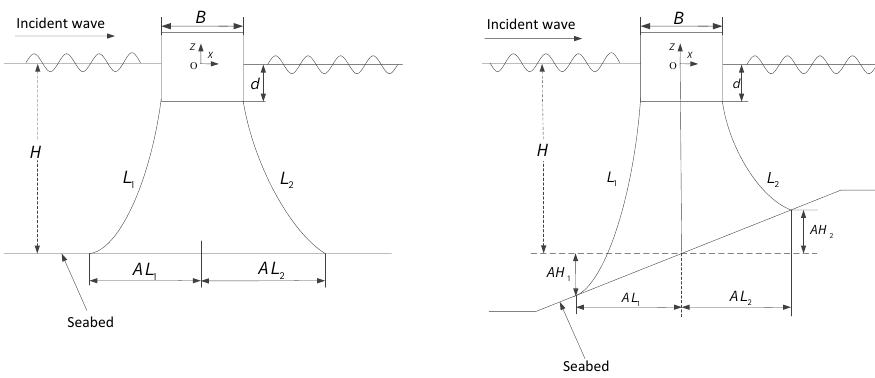
Figure 9. Profiles of symmetrical and asymmetrical seabeds with mooring lines.